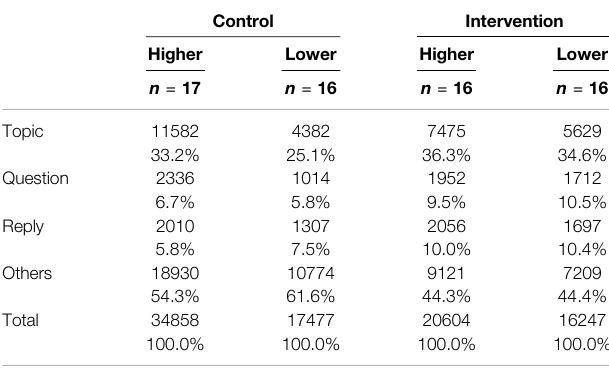
TABLE 5 | The numbers and proportions of four types of utterances within the subgroups. Control